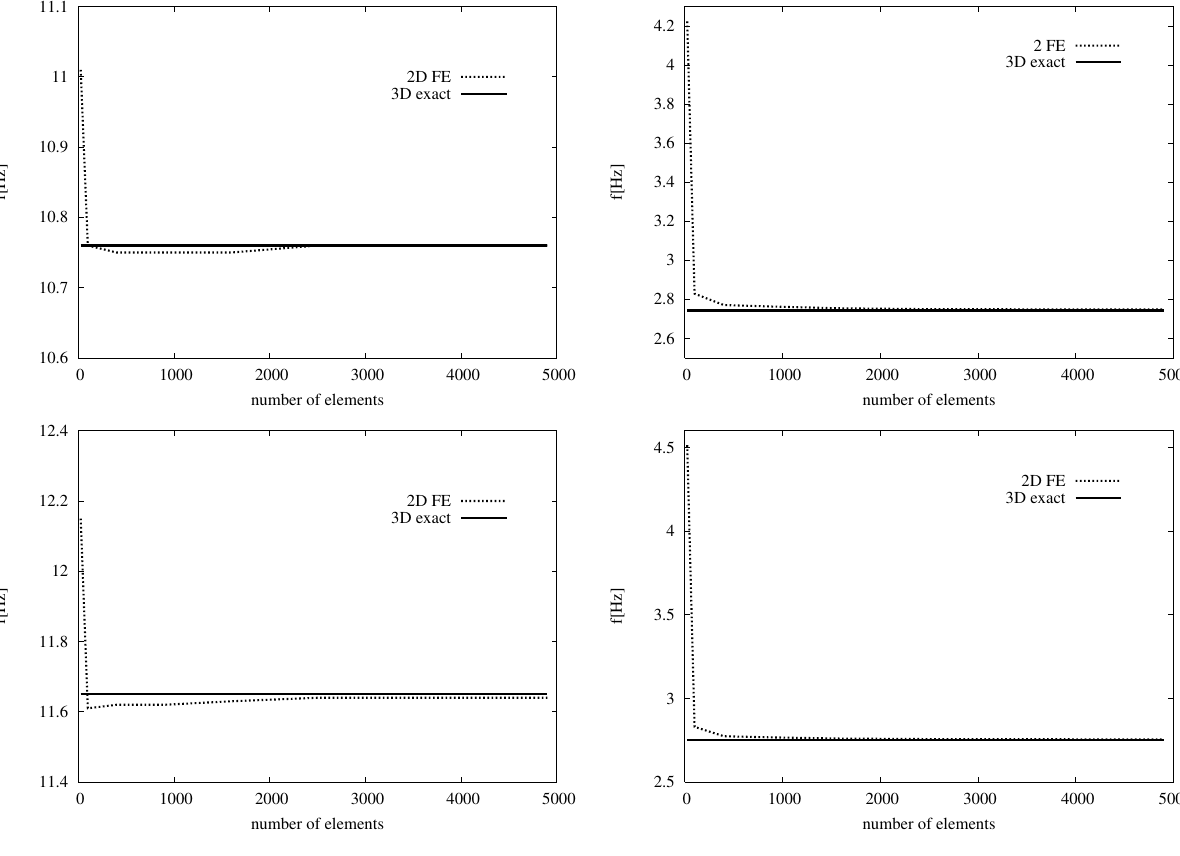
Figure 8: Third assessment for the 2D FE solution, simply supported composite cylinder 90 ∘ /0 ∘ /90 ∘ with thickness ratio R α /h=1000. Frequency f[Hz] vs. number of elements for the mode (22,1) (at the top) and for the mode (24,1) (at the